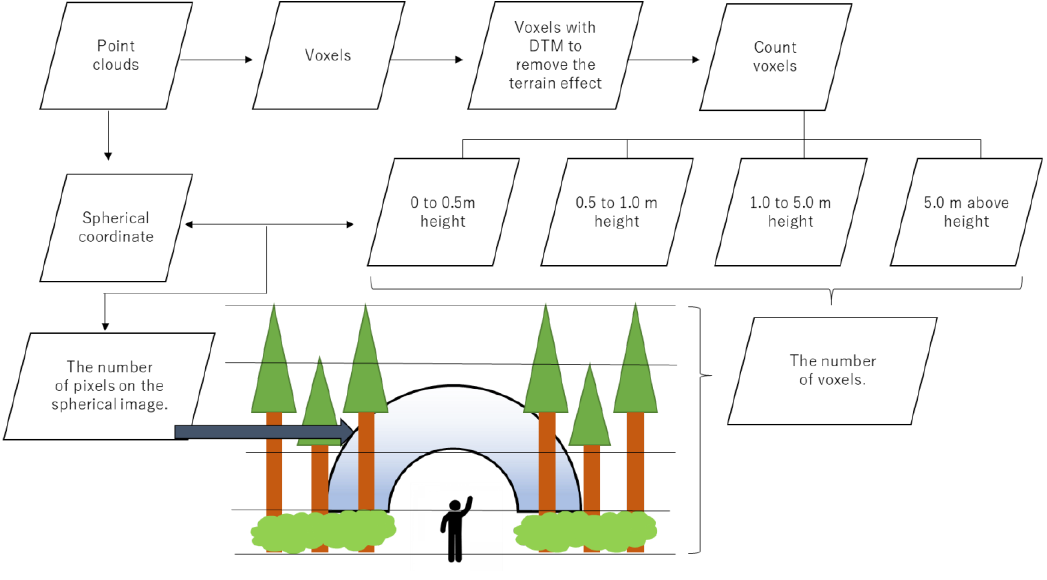
Figure 2. TLS data analysis procedure.